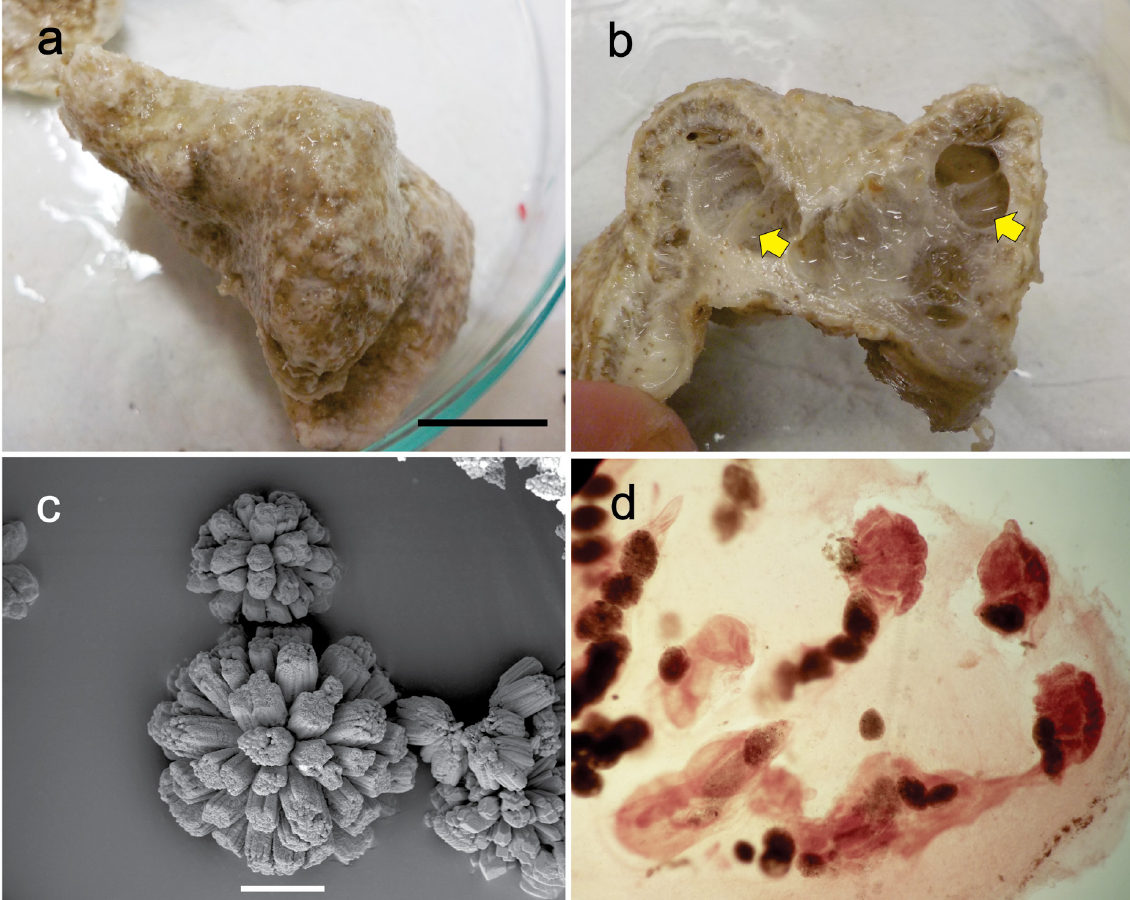
Fig. 8. Polysyncraton magnetae Hastings, 1931, type specimen (NHM 1930.12.17.46). a . Preserved colony. b . Cross section of the colony showing cavities found in the median region (arrows). c . Spicules. d . Cross section of a decalcified colony. Scale bars: a = 1 cm; c = 10